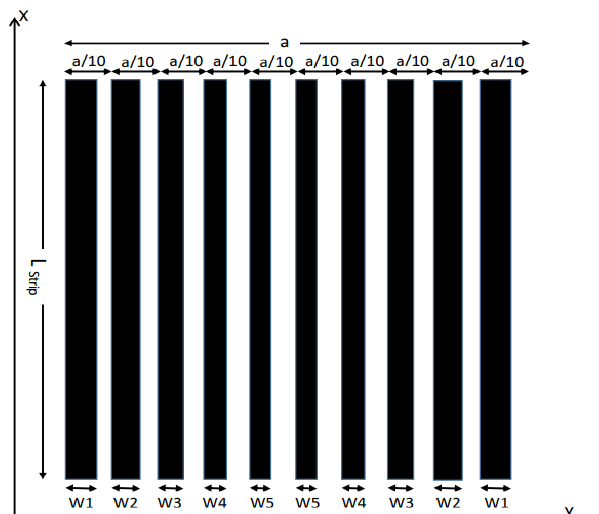
Figure 5: Geometry of a unit cell of the proposed sinusoidally modulated leaky wave antenna.